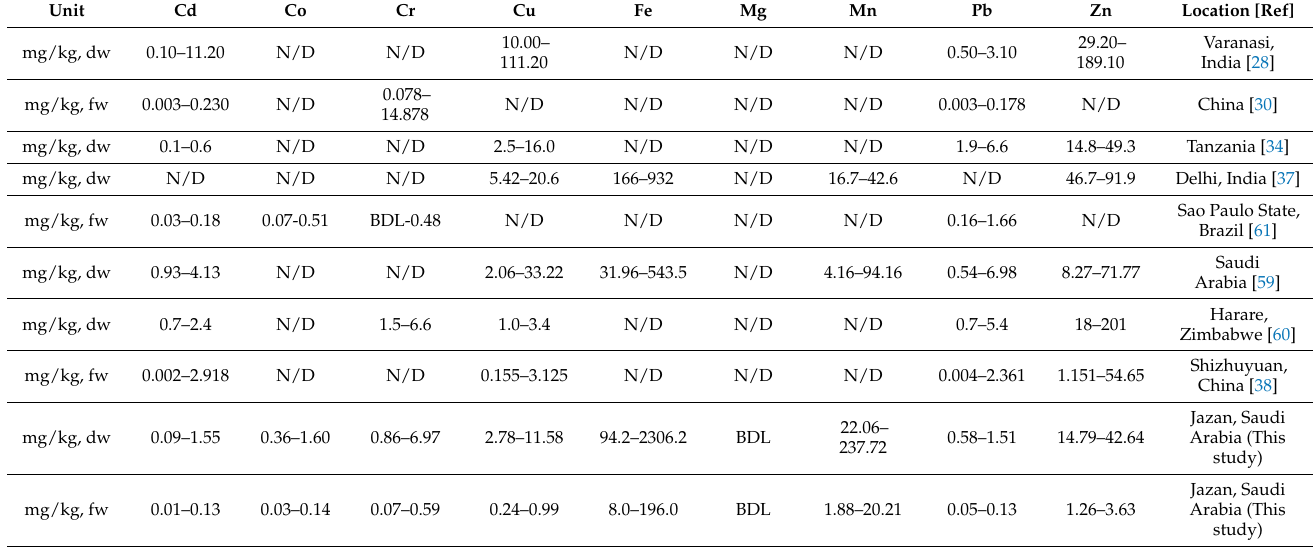
Table 3. Comparison of analyzed trace elements’ concentrations in vegetables in this investigation with those reported by previous